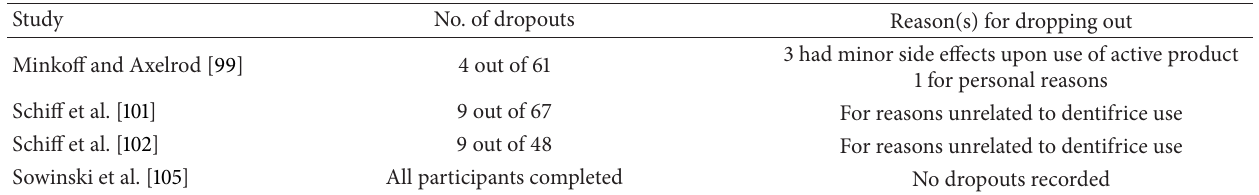
Table 7: Number of dropout participants from the included studies and the reasons for dropout (4 studies).